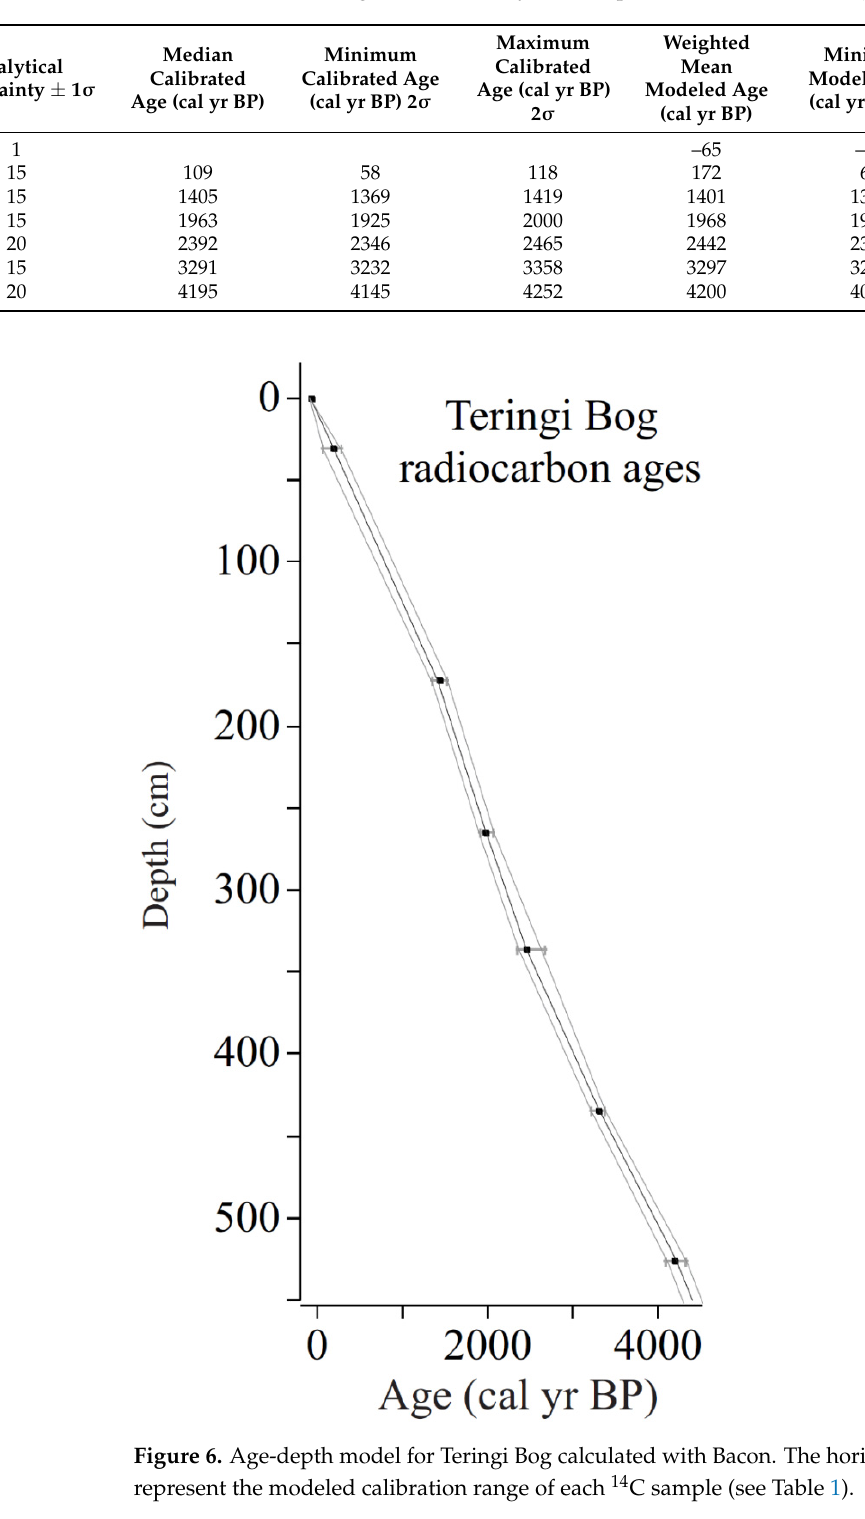
Table 1. Radiometric ages used in study. All samples were measured on Sphagnum stems.